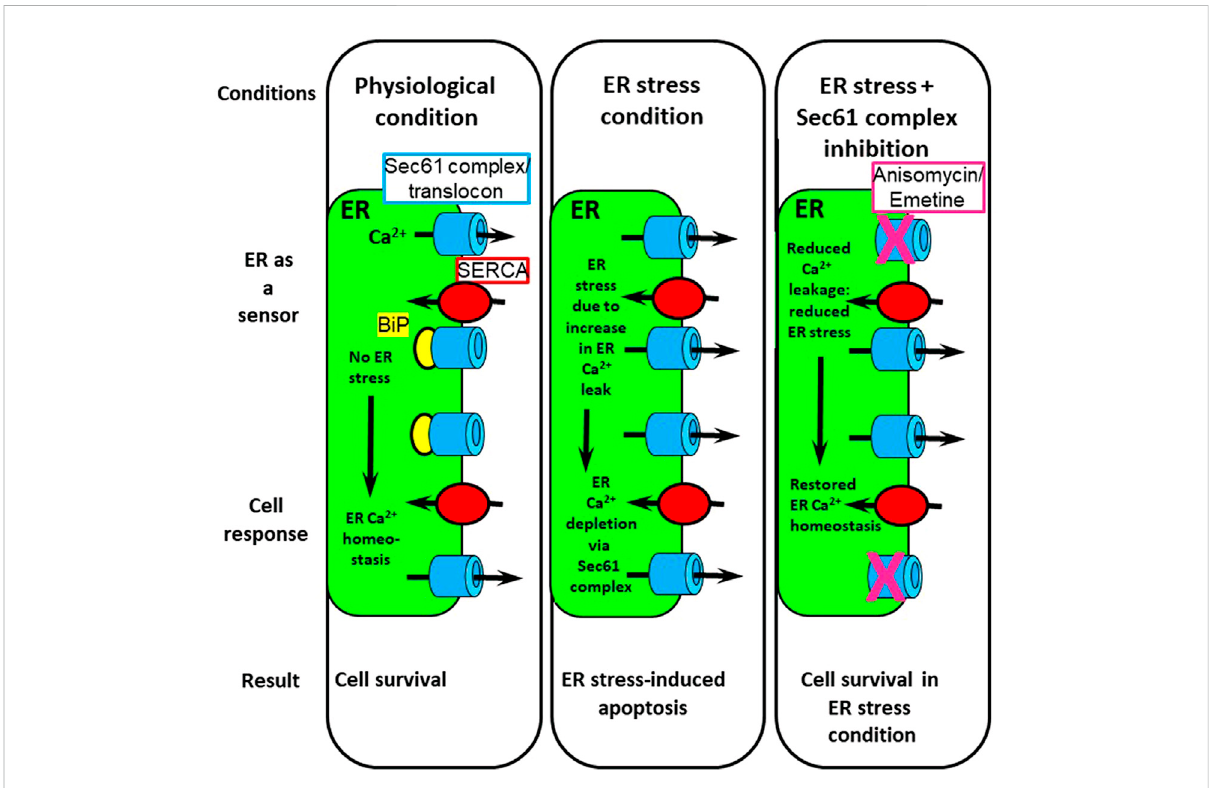
FIGURE 2 InvolvementoftheSec61complex/transloconincellsurvival.Inphysiologicalcondition, ERCa 2+ homeostasisisduetoabalancebetweenCa 2+ leak and Ca 2+ re-uptake by SERCA pumps. ER stress triggers Ca 2+ depletion of the ER Ca 2+ stores via an increase in Ca 2+ leakage through the Sec61 complex. Pharmacological inhibition of the Sec61 complex with anisomycin or emetine during ER stress restores ER Ca 2+ homeostasis and protects cells from apoptosis. Adapted from Cassel et al., Plos One, 2016 (Cassel et al., 2016) licensed under a Creative Commons Attribution 4.0 International